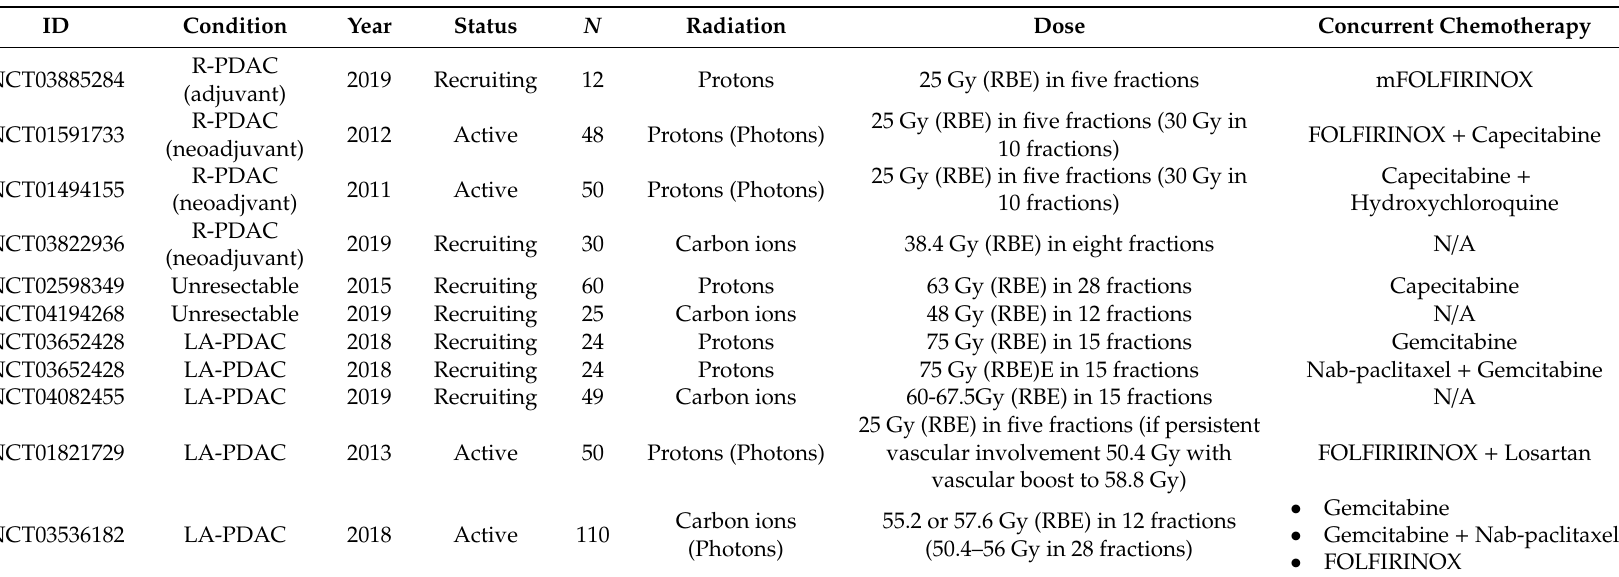
Table 1. Ongoing clinical trials for pancreatic cancer patients treated with protons or carbon